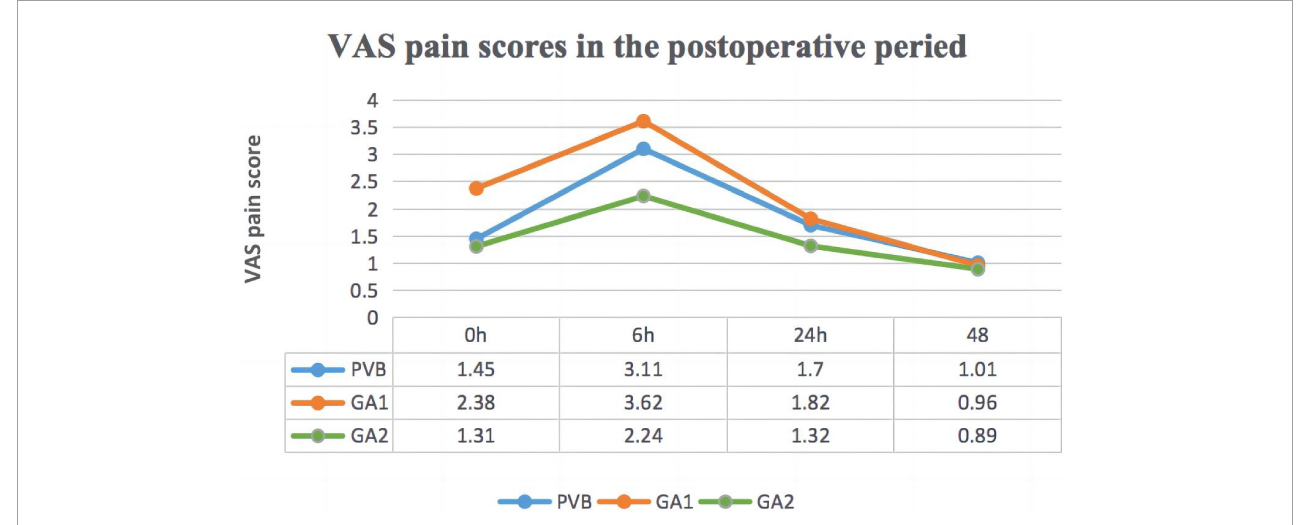
FIGURE2 The visual analog scale (VAS) pain scores in the postoperative period. PVB group, paravertebral block group; GA 1 group, general anesthesia without PICA Group; GA 2 group, general anesthesia with PICA